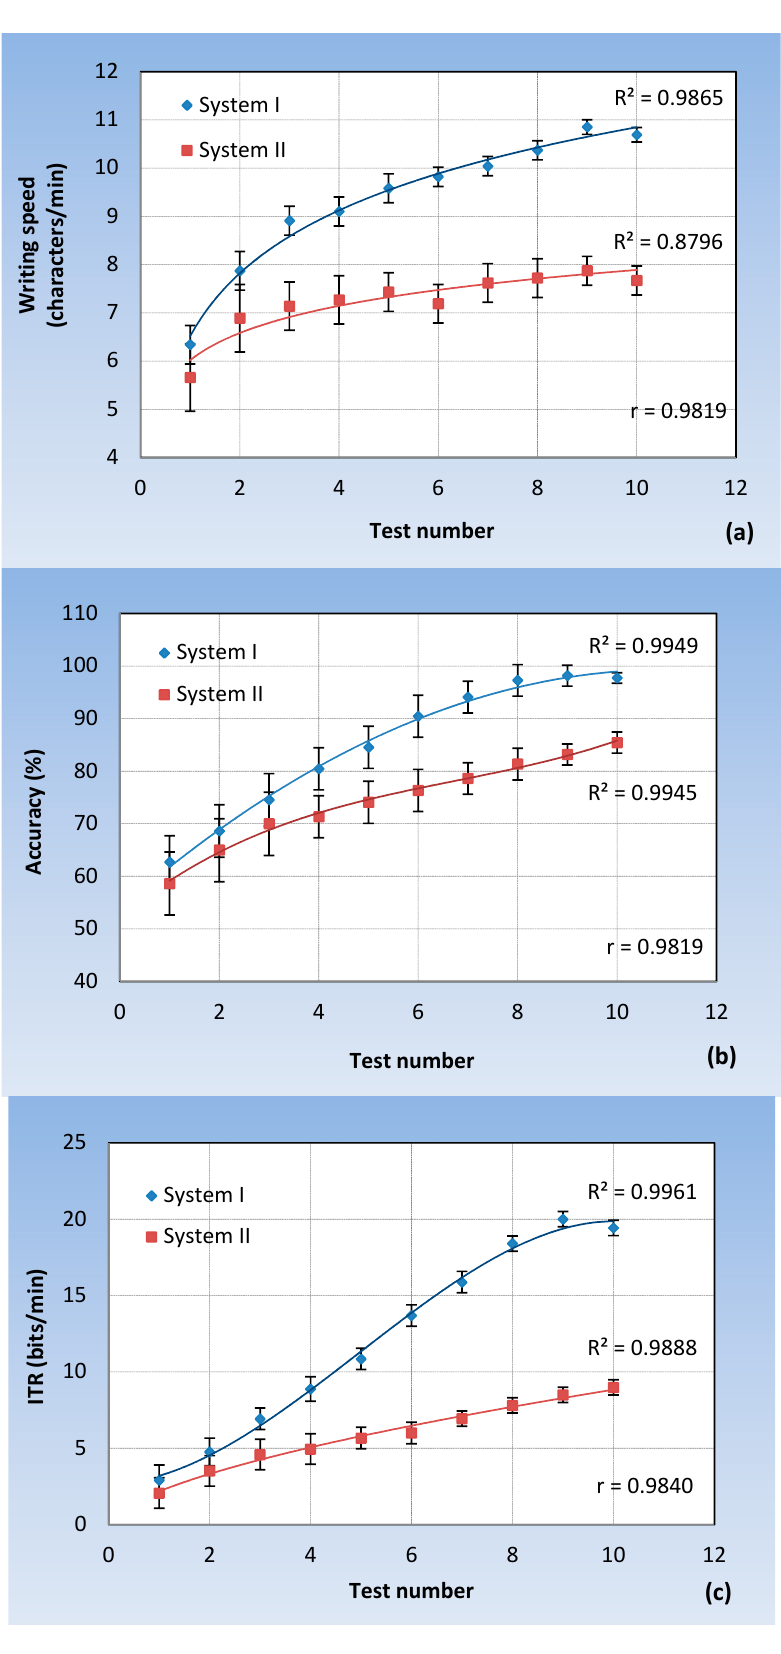
Figure 14. Evolution of: ( a ) the writing speed; ( b ) accuracy; ( c ) the ITR with the number of tests.